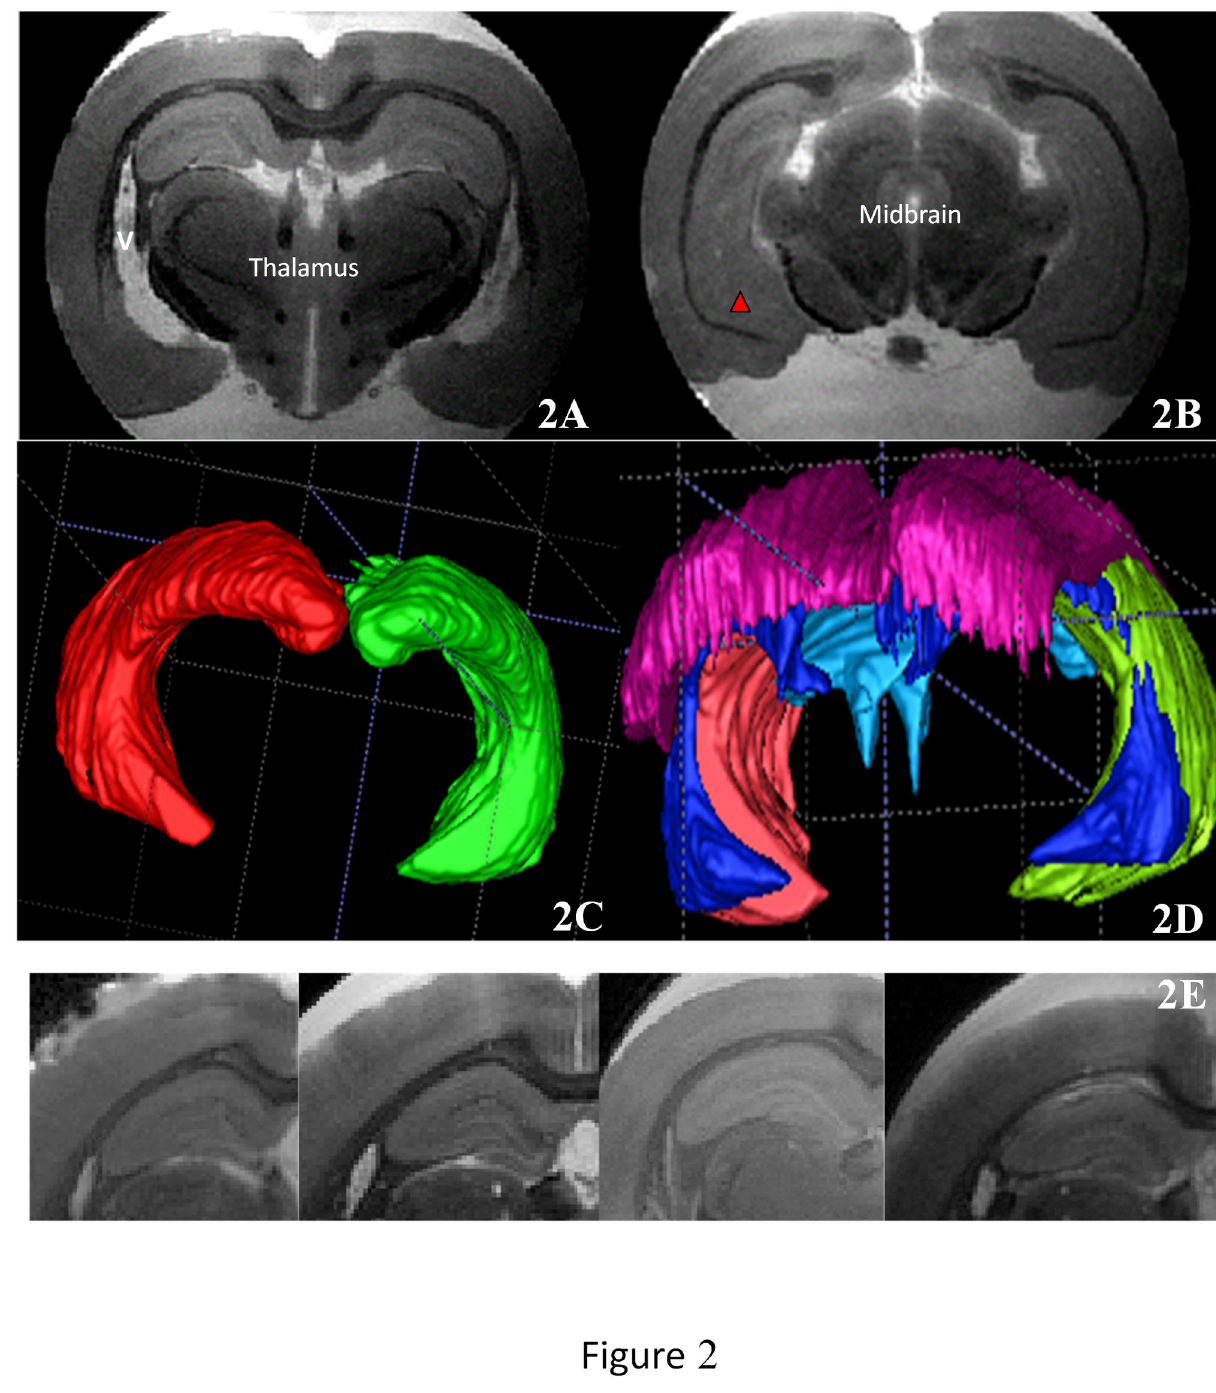
Figure 2. 2A: 3D hippocampus and other brain structures imaging. 2A and 2B: limits of the hippocampus with adjacent structures. 2C: three-dimensional view of the hippocampus. Red: right hippocampus, green: left hippocampus. 2D: results of the segmentation of the other structures (Red: corpus callosum, blue: lateral ventricles, sky blue: fourth ventricle). 2E: Hippocampus layers obtained by our four sets of parameters from A1 (left) to A4 (right). The better visualisation of the six hippocampus layers is obtained with our A3 sets of parameters.